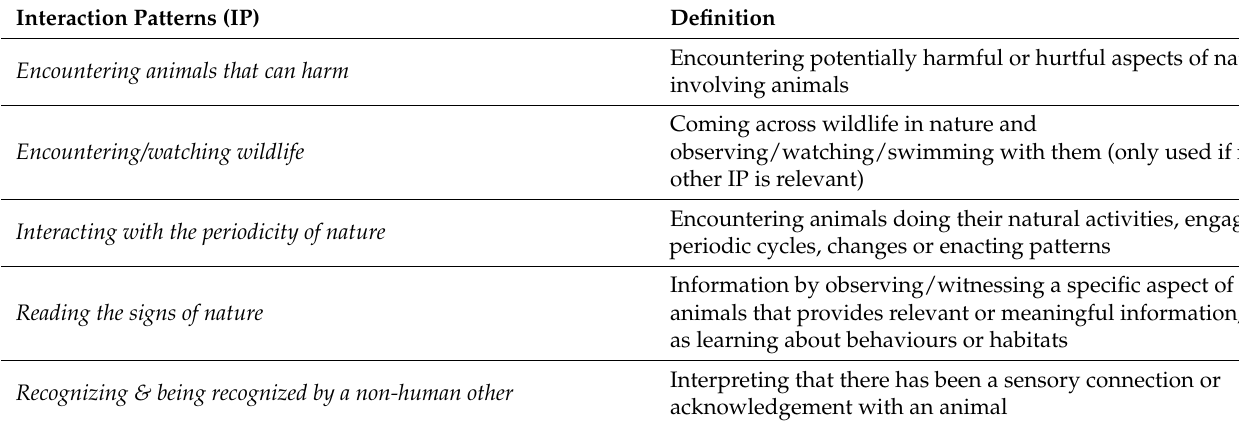
Table 1. Interaction Patterns and definitions.